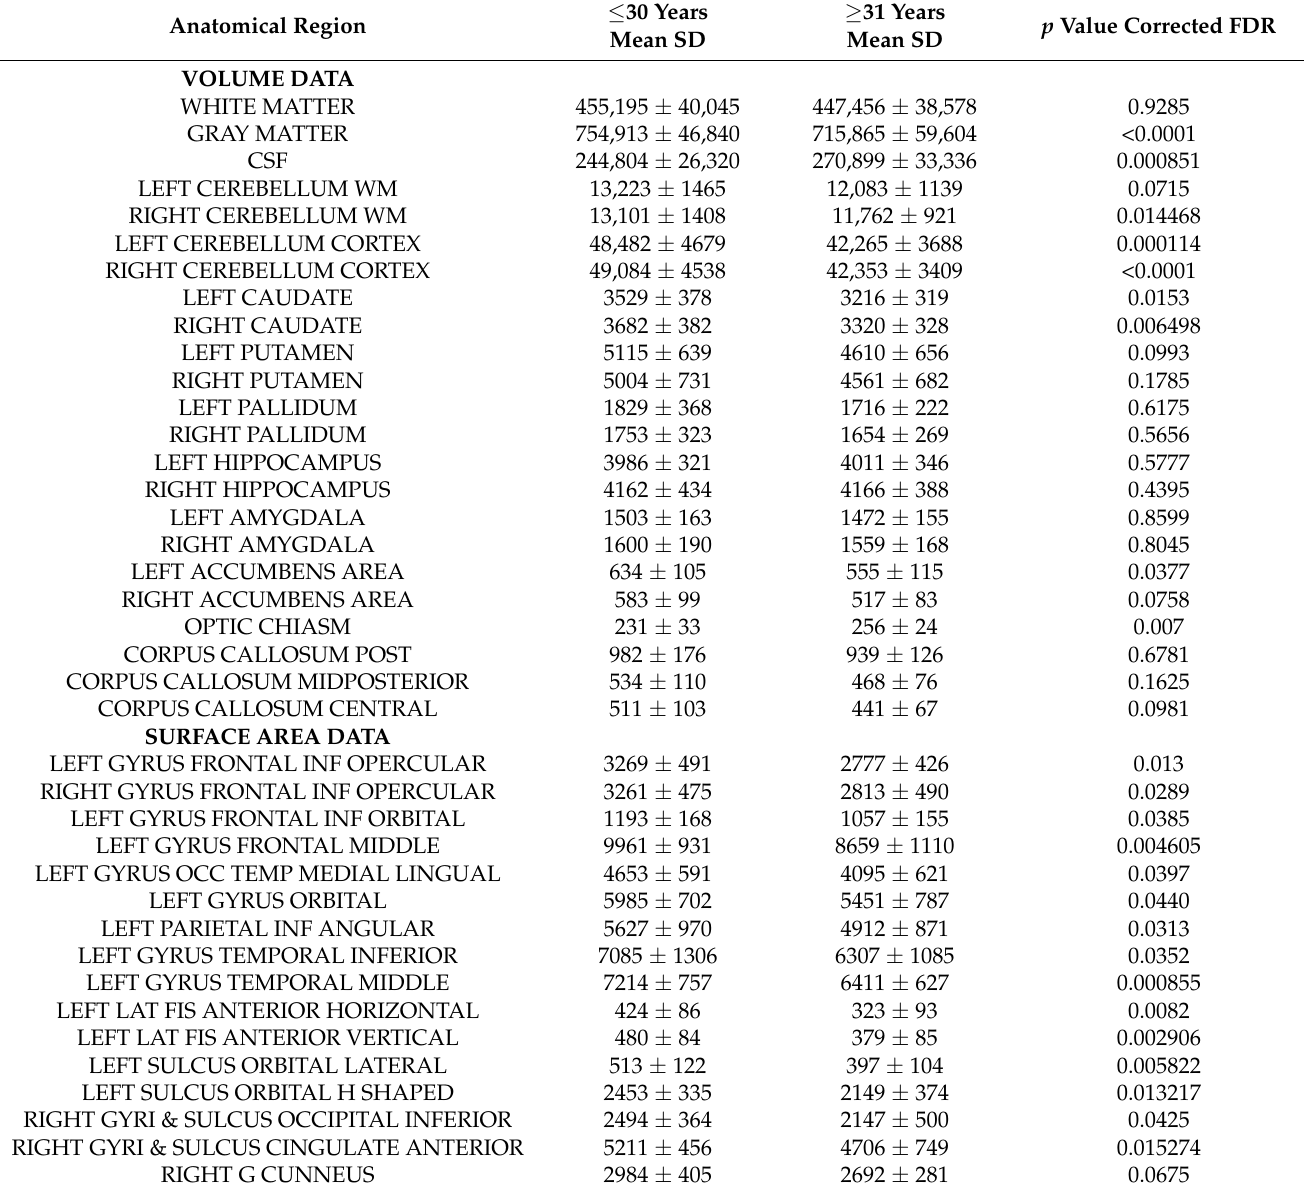
Table 2. MRI volume corrected for Multiple Comparisons in MMC subjects: p values after correcting ICV linearly and FDR. All subjects are